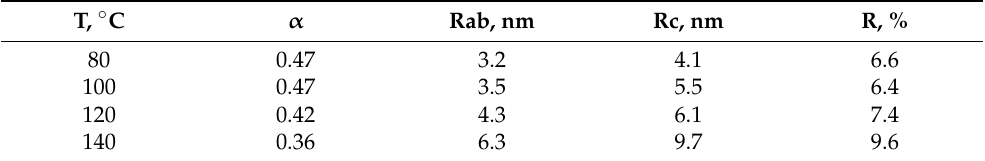
Figure 5. Debye-simulated XRD patterns for Cd 0.7 Mn 0.3 S nanoparticles of ellipsoidal shape contain- ing SFs in comparison with experimental data. Optimized parameters are lattice constants, radii of ellipsoids, and probability of SFs. Table 1. Optimized values of probability of SFs in WZ structure ( α ), radii of ellipsoidal particles in ab plane (Rab) and in c direction (Rc) in dependence on temperature